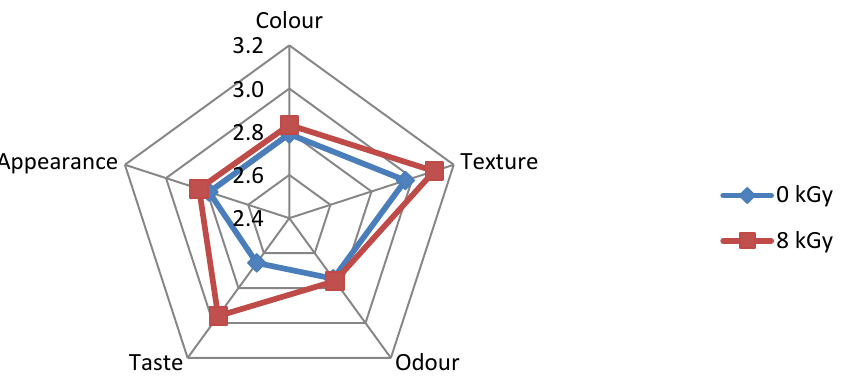
Figure 2. Sensory evaluation of non-irradiated and irradiated bacem tofu.